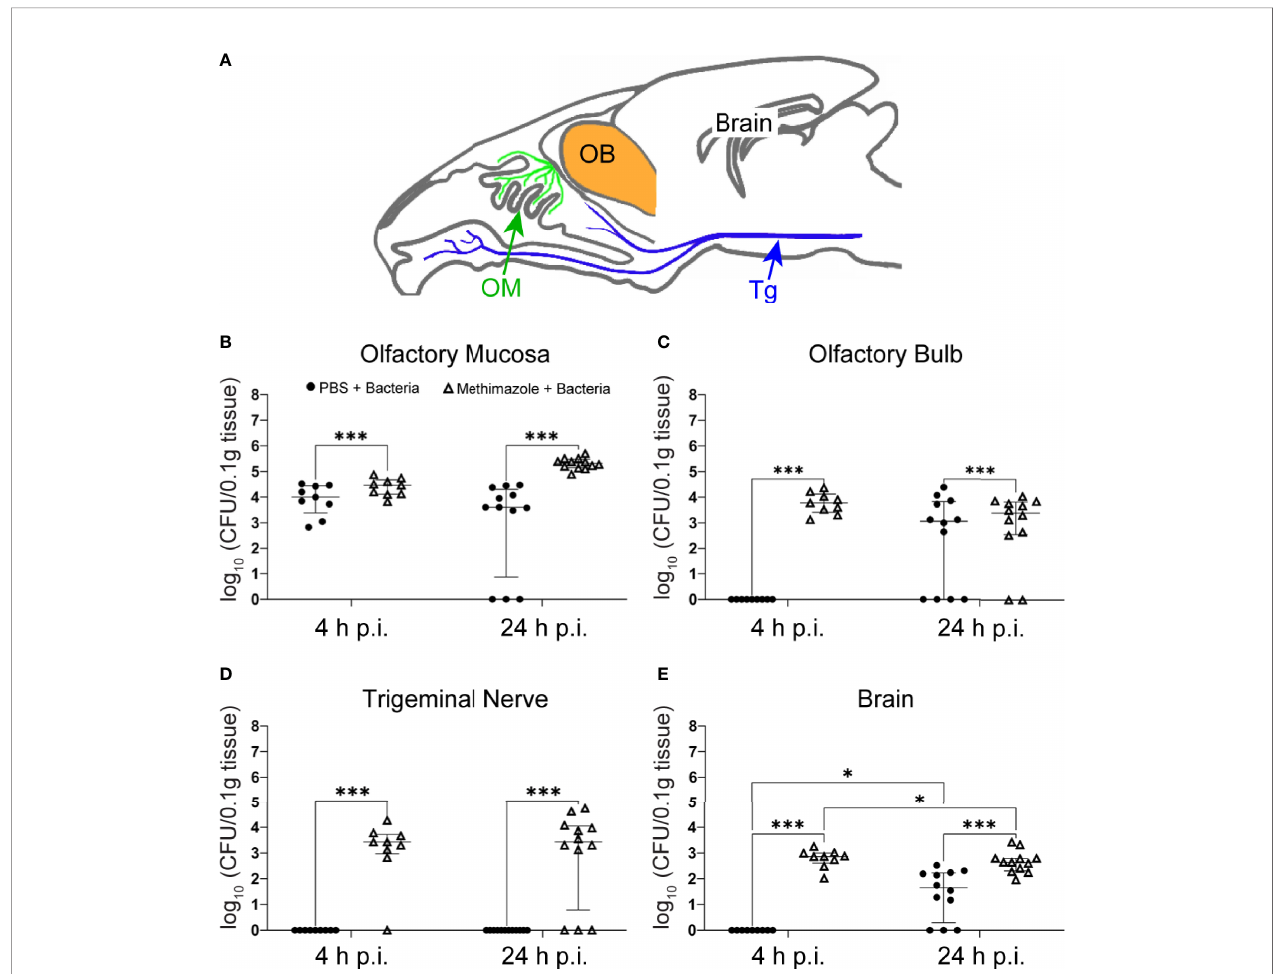
FIGURE 1 | S. agalactiae can invade the CNS via the olfactory nerve but infects the trigeminal nerve only after epithelial injury. Mice were treated with either methimazole or vehicle (PBS), followed by intranasal inoculation with S. agalactiae (1 x 10 6 CFU) or vehicle (also PBS). (A) Schematic of sagittal view of mouse brain, with olfactory mucosa (OM) and olfactory nerve (green), trigeminal nerve (Tg; blue), olfactory bulb (OB; orange), and brain. Tissue of Tg was collected from region shown by blue arrow. Graphs show the amount of S. agalactiae isolated from tissues 4 h and 24 h after intranasal inoculation for the four groups, (1) PBS ! PBS (data not shown as no bacteria was isolated, Supplementary Data Table 1 ), (2) methimazole ! PBS (data not shown as no bacteria was isolated, Supplementary Data Table 1 ), (3) PBS ! S. agalactiae and (4) methimazole ! S. agalactiae . (B) olfactory mucosa, (C) olfactory bulb, (D) trigeminal nerve and (E) brain. Data are pooled results from two independent biological experiments and are shown as median and interquartile range (4 h timepoint = 9 mice per group, 24 h timepoint = 12 mice). The S. agalactiae load from the different groups were compared using two-way ANOVA with signi fi cance determined using Tukey ’ s multiple comparison test, *p ≤ 0.05, ***p ≤ 0. 001. For mice with zero bacterial counts, these were assigned a value of 1 in order to plot on log 10